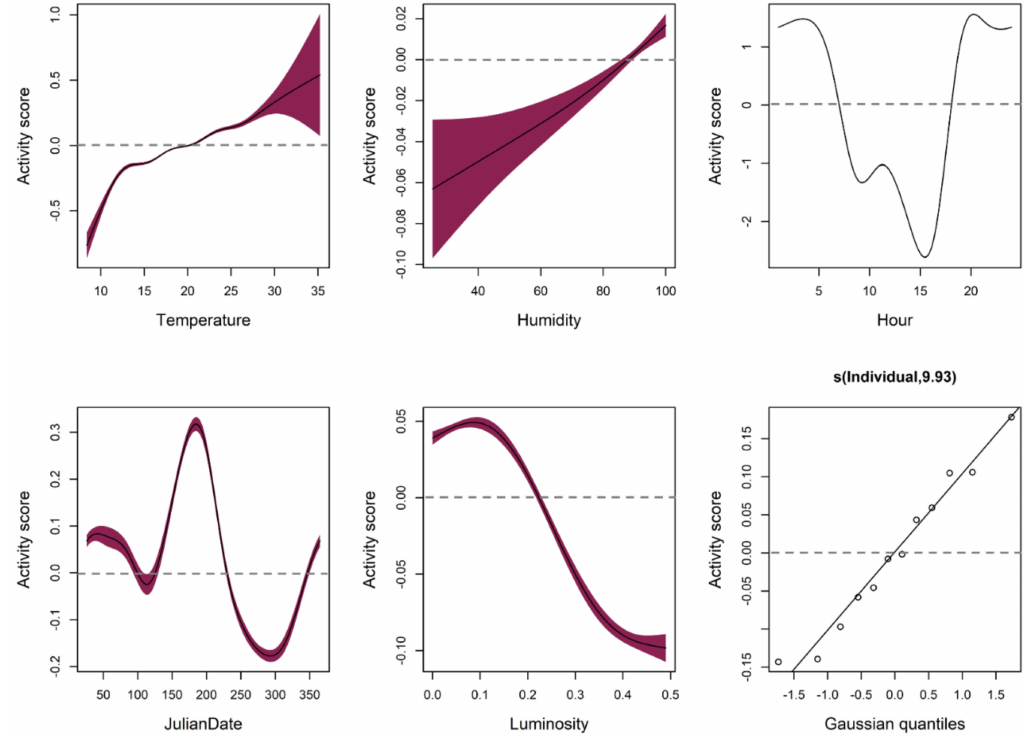
Figure 2. Smooth terms estimated via Generalized Additive Models to explain the influence of moon luminosity, seasonality (Julian date), temperature ( ◦ C), relative humidity, time of the day, and individuals (random effect) on the activity levels of Javan slow lorises Nycticebus javanicus in Cipaganti, West Java. Data were collected via accelerometers deployed on 12 Javan slow lorises (six females and six males) between June 2014 and October